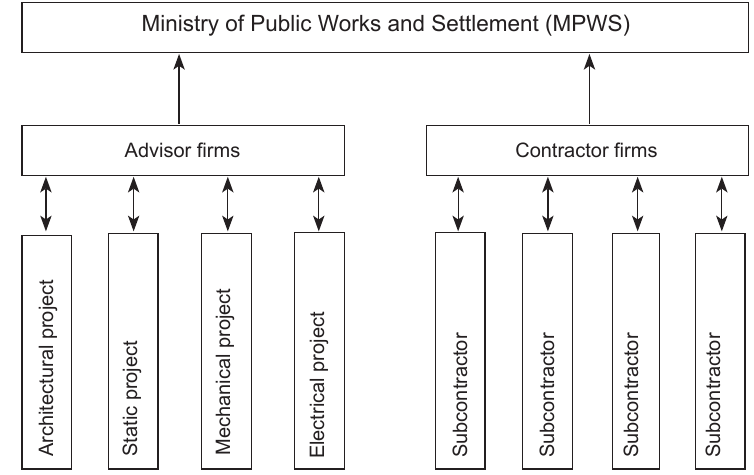
figure 5. 1999 Marmara earthquake